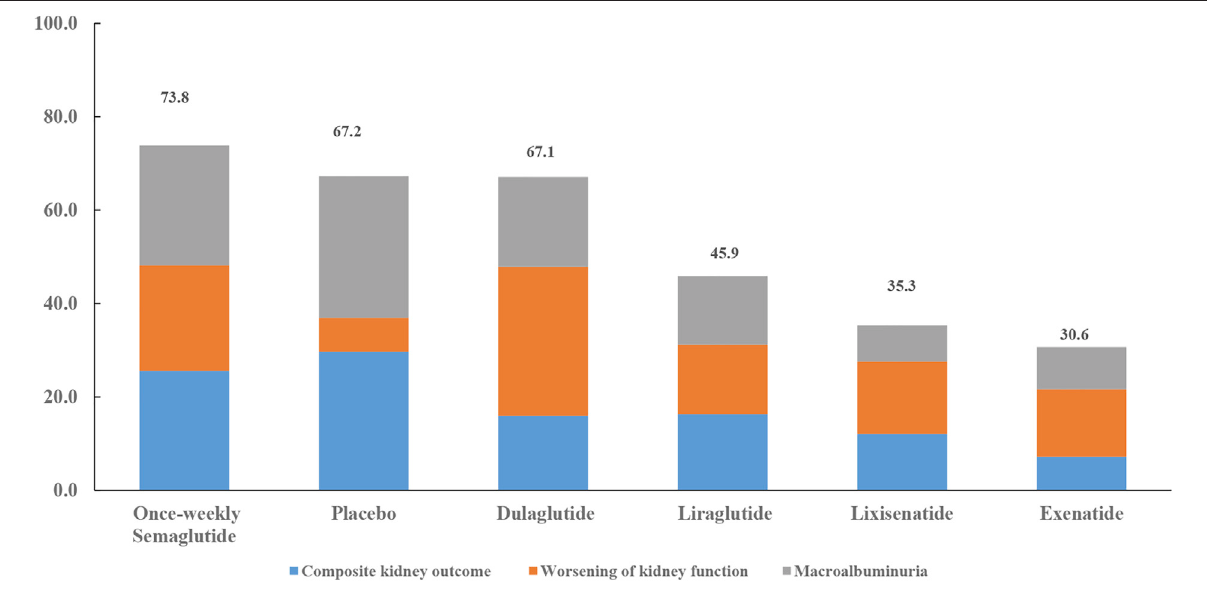
FIGURE 4 | Ranking of treatments according to composite kidney outcome, worsening kidney function, and macroalbuminuria. Cumulative percentages after normalization(0 – 100%)areshowninthekey.Eachinterventionwasscoredwithpointsuptoamaximumof33.3foreachprimaryoutcome(overallmaximumscore,100) with data from rankograms and